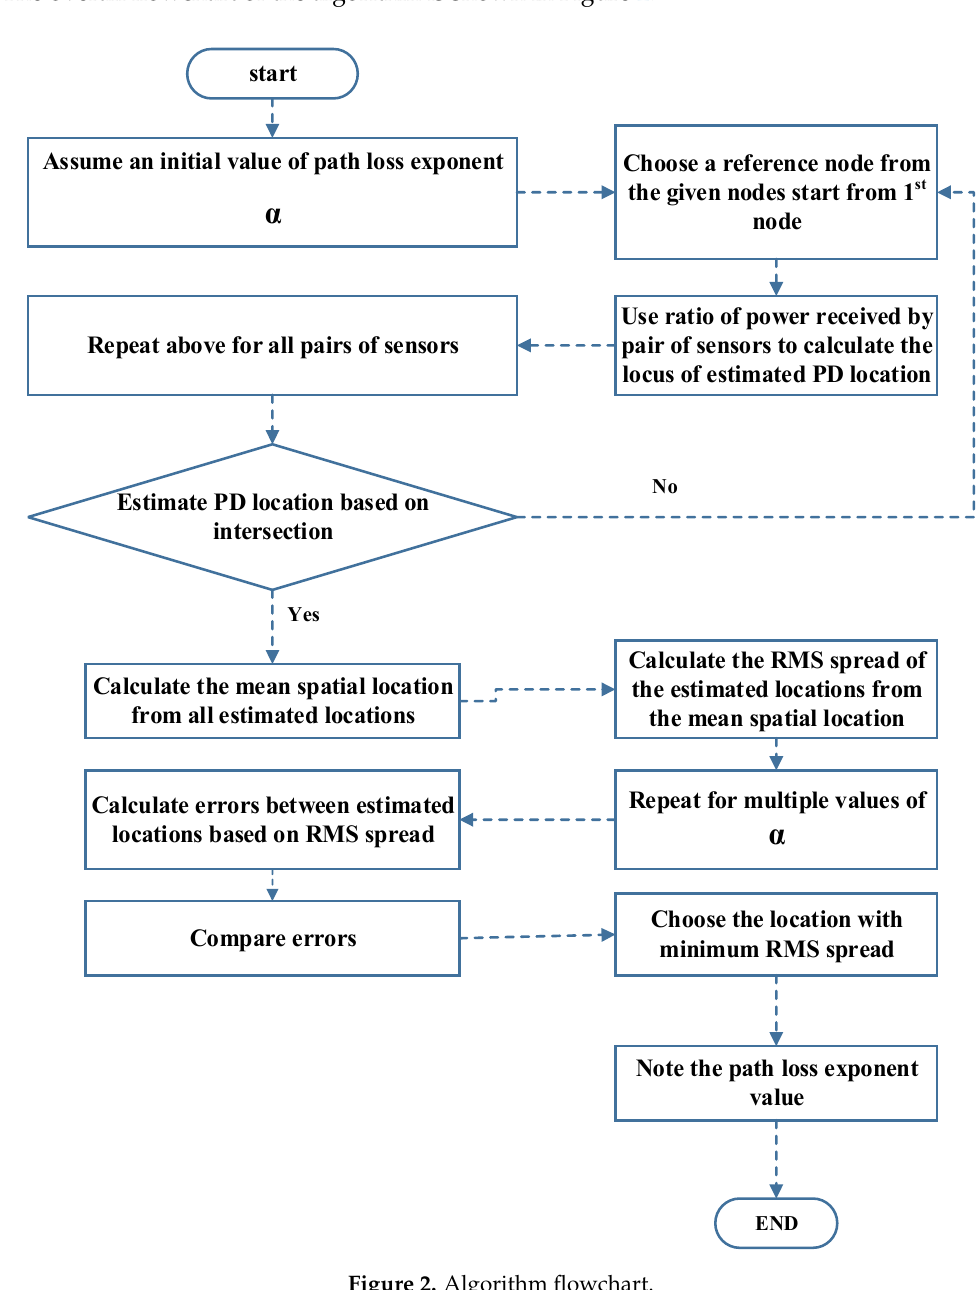
Figure 2 . Algorithm flowchart. Figure 2. Algorithm